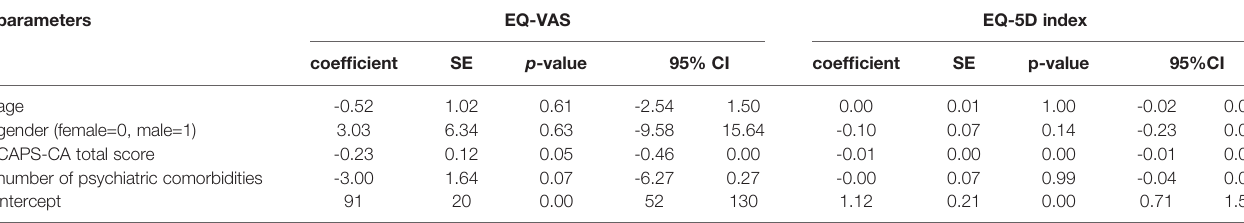
TABLE 5 | Determinants of health-related quality of life measured by the EQ-VAS and EQ-5D index (n=87).